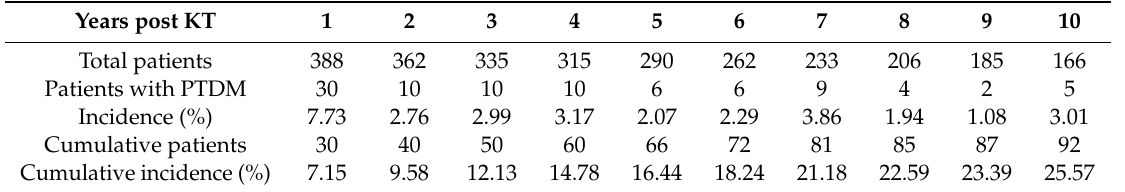
Table 2. Incidence of PTDM during the follow-up periods ( n = 425).